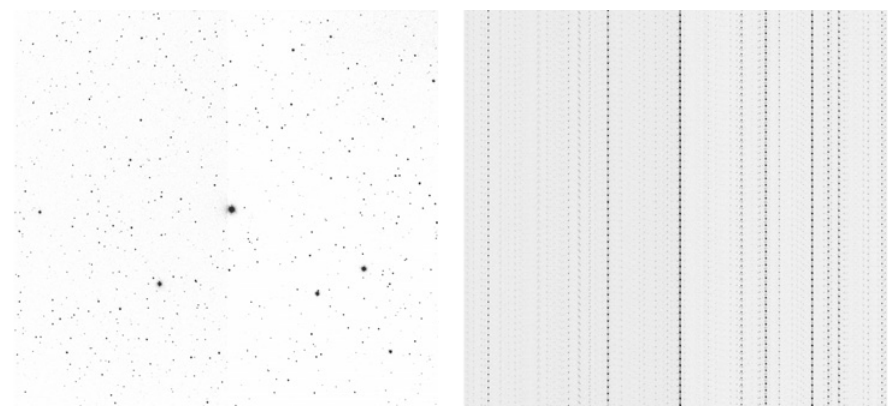
Fig. 1. An illustrated star field taken (left) by standard ’stare’ imaging and (right) by the pause-and-shift (’zipper’) procedure.